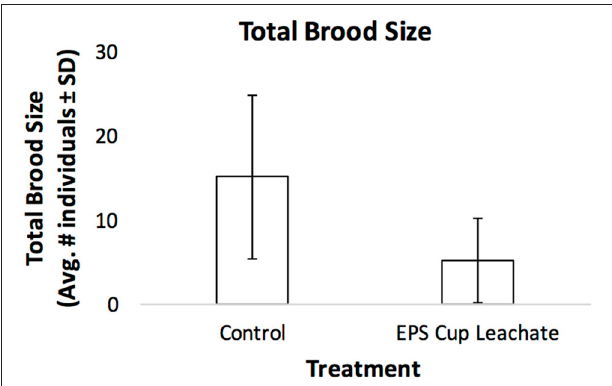
FIGURE 2 | Total brood size of C. dubia exposed to the EPS cup leachate and the negative control. Each bar represents the mean total brood size of each treatment and the error bars represent the standard